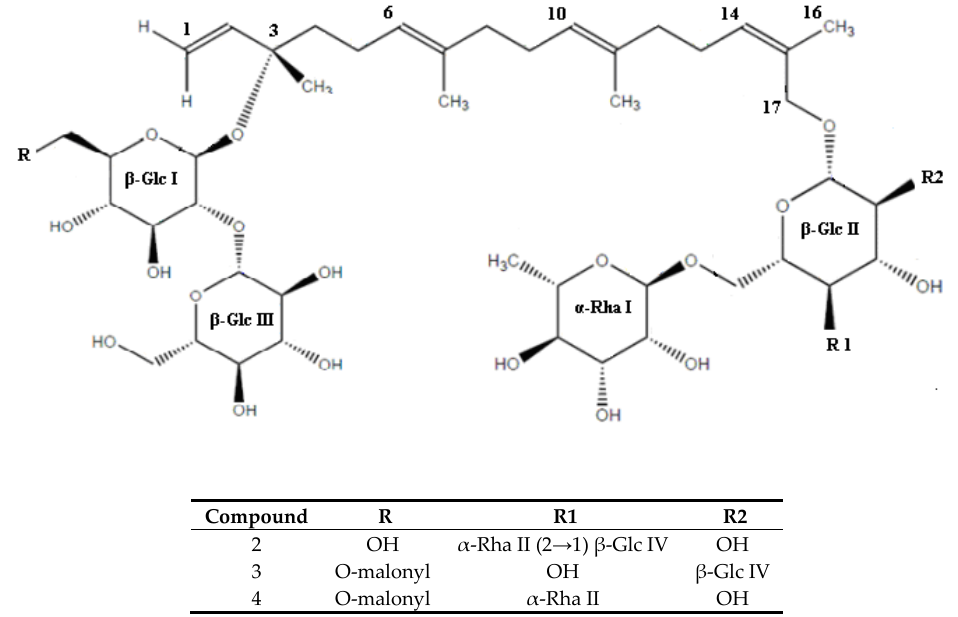
Figure 2. Structural representation of the newly identified compounds.